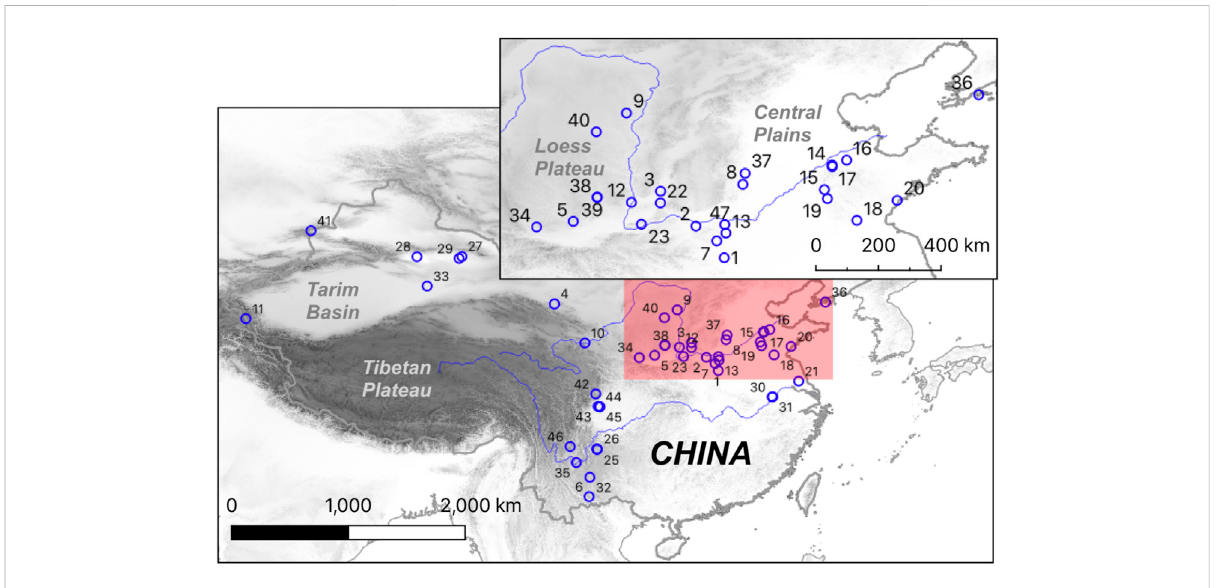
FIGURE 1 Archaeological sites with bioavailable strontium isotope data in China and the sites were presented in the order of year of publication. 1 Jiahu (Yin et al., 2008); 2 Erlitou (Zhao et al., 2011a; 2012b); 3 Taosi (Zhao et al., 2011b; Zhao and He, 2014); 4 Heishuiguo (Zhao, 2012); 5 Zaoshugounao (Lan, 2017); 6 Mayutian (Zhang et al., 2014); 7 Wadian (Zhao et al., 2012a; Zhao and Fang, 2014); 8 Yinxu (Zhao et al., 2015); 9 Shimao (Zhao et al., 2016a); 10 Lajia (Zhao et al., 2016b; Zhao et al., 2018); 11 Jirzankal (Wang et al., 2016); 12 Liangdaicun (Chen, 2012); 13 Wangjinglou (Zhao et